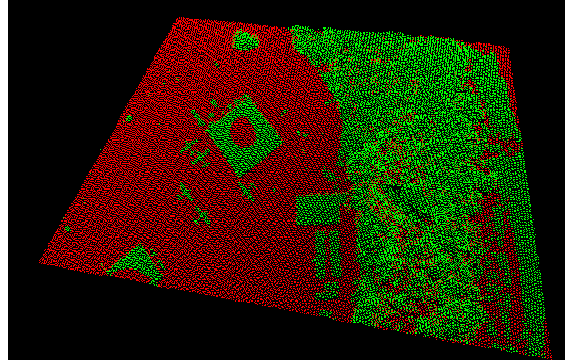
Figure 2. Point cloud data to be